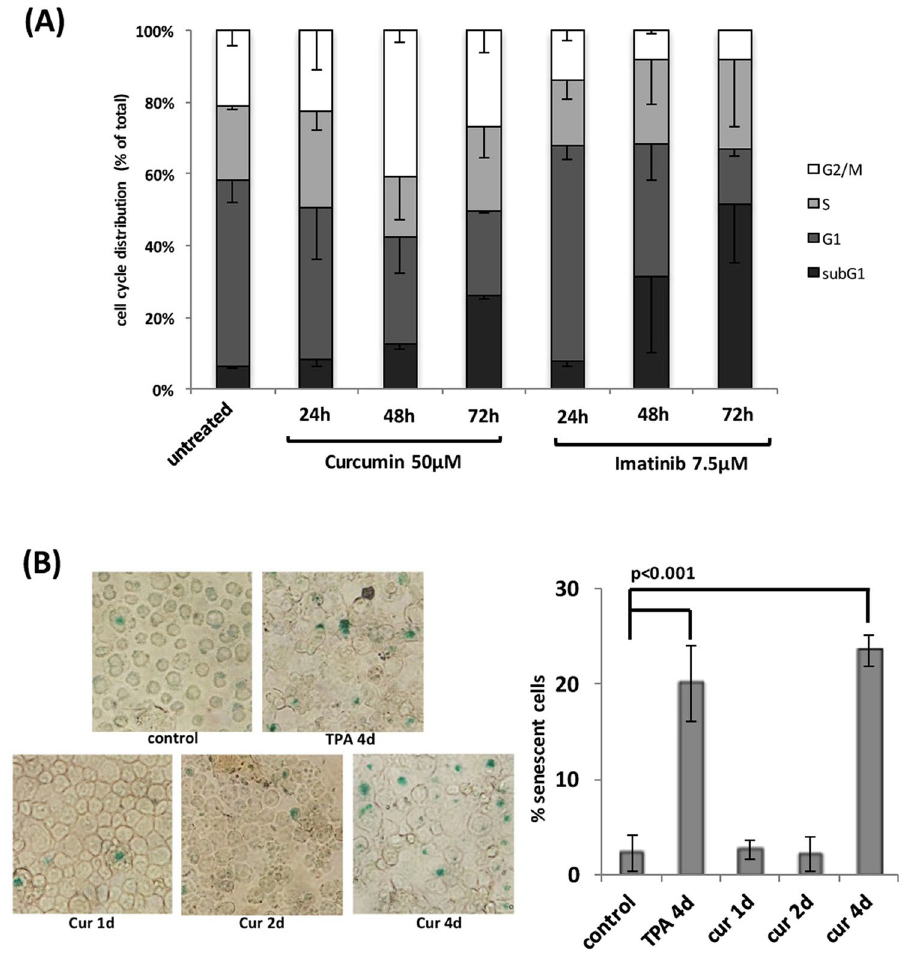
Figure 3. Effects of curcumin on K562 cells in vitro . ( A ) K562 cells (5 × 10 5 cells/mL) were treated with curcumin (50 μ M) and imatinib (7.5 μ M) for 24, 48, and 72 hours, and then subjected to a cell cycle analysis. ( B ) K562 cells (2 × 10 5 cells/mL) were treated with curcumin (50 μ M) for 1, 2, and 4 days, harvested on the cover glass by cytospin, and subjected to β -galactosidase staining. As a positive control, cells were treated with TPA (16 nM) for 4 days. The percentages of senescent cells ( β -galactosidase-positive cells) were calculated (n =